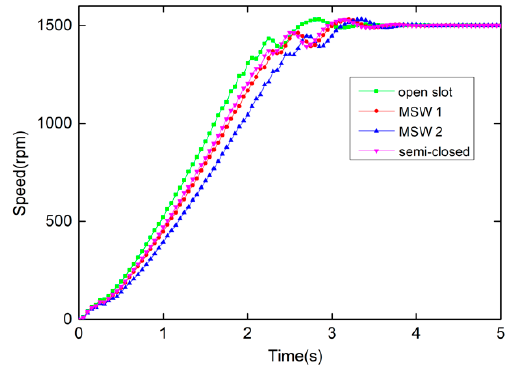
Figure 16. Speed vs. time.